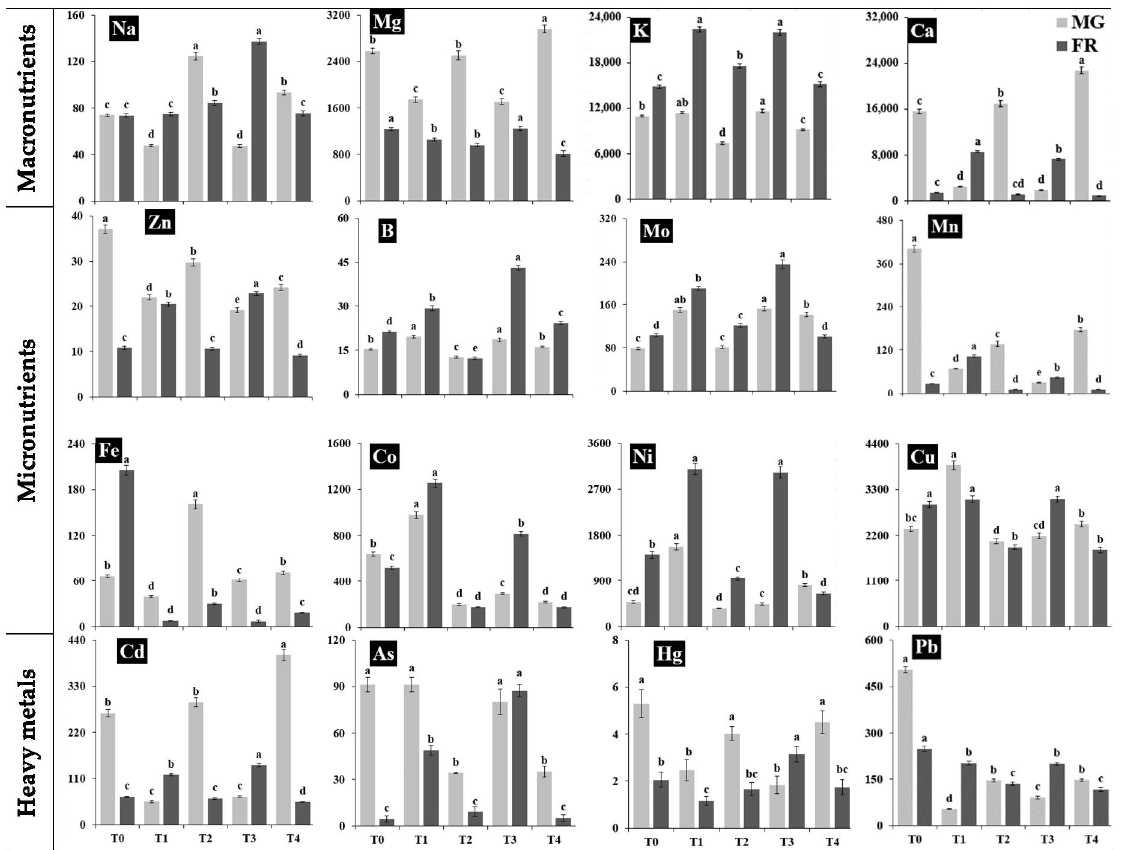
Figure 4. Level of mineral nutrients and heavy metals in loquat seeds as affected by exogenous applications of Mg, Zn, and B. Different letters indicate a significant difference among treatments for each series according to Fisher’s least significant difference test at α = 0.05. Vertical bars indicate average ± standard error (four replicates, p ≤ 0.05). T 0 —control; T 1 —2% MgSO 4 · 7H 2 O, T 2 —0.1% ZnSO 4 · 7H 2 O, T 3 —0.2% Na 2 B 4 O 7 · 10H 2 O and T 4 —T 1 +T 2 +T 3 (1:1:1), MG—mature green stage, FR—fully ripe stage.